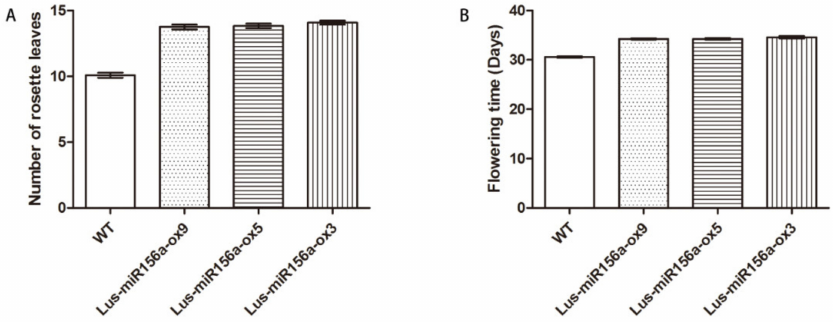
Figure 6. Number of rosette leaves and flowering time of the transgenic lines and wild type. ( A ) Number of rosette leaves, ( B ) Flowering